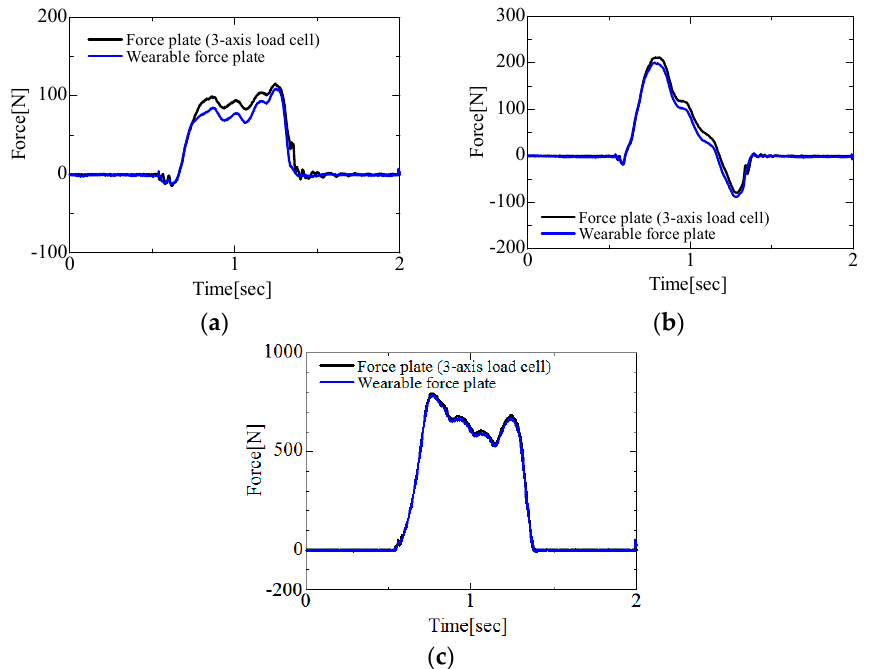
Figure 5. Results for force components on the force plate installed with 3-axis load cells and the wearable force plate; ( a ) F x (lateral direction) component; ( b ) F y (traveling direction) component; ( c ) F z (vertical direction)